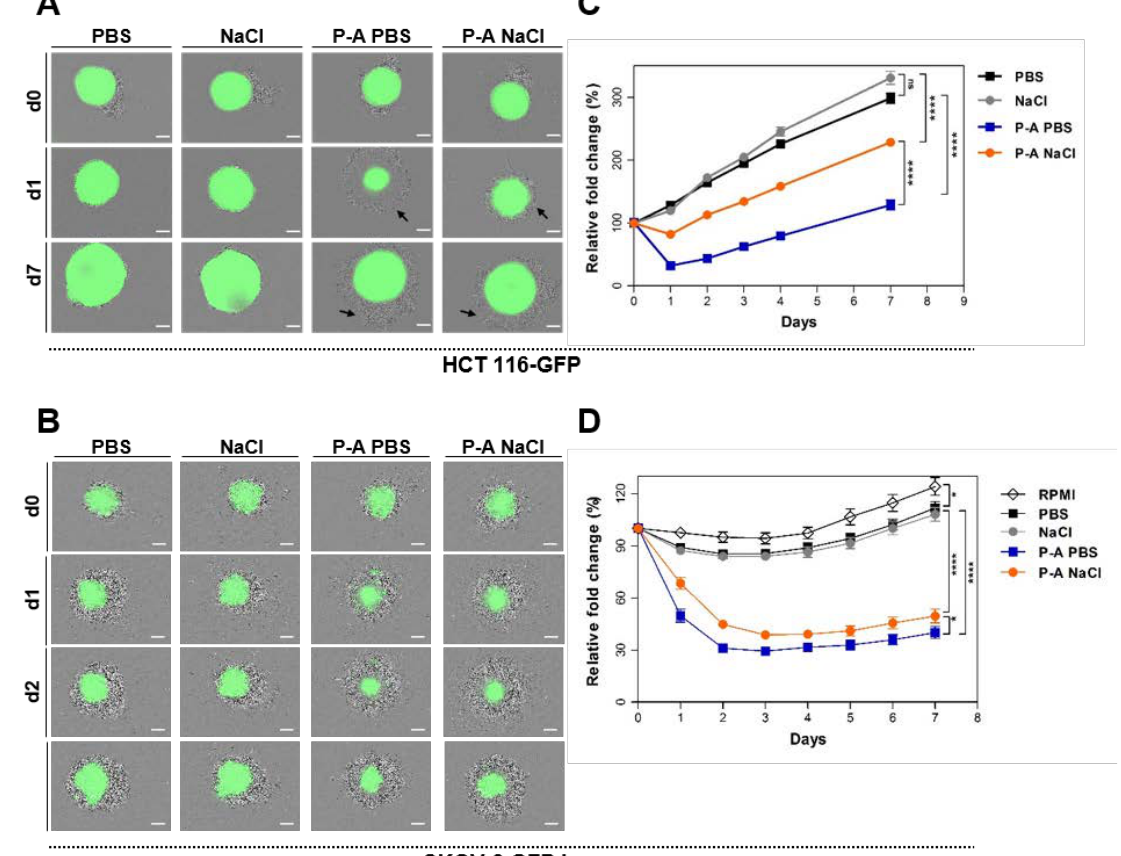
Figure 1. Spheroids’ responsiveness to plasma-activated PBS (P-A PBS) and plasma-activated NaCl (P-A NaCl). Spheroids were incubated in PBS, NaCl, P-A PBS or P-A NaCl for 4 h before being cultured for 7 days for growth follow-up. ( A , B ) Bright-field and green fluorescence micrograph overlays (viable cells) of HCT 116-GFP ( A ) and SKOV-3 GFP Luc ( B ) spheroids at d0 (before treatment), d1, d2, and d7 after treatment. The scale bar is set at 200 µ m. Black arrows indicate cell debris. ( C , D ) Graphs representing the relative fold change (percentage) of spheroid areas as a function of time. Areas were measured from the GFP fluorescence micrographs. Two-way ANOVA, **** p < 0.0001; ns: non-significant p > 0.05. N = 6 and 3 independent experiments for HCT 116-GFP and SKOV-3 GFP Luc, respectively, with n = 8 spheroids per experiment.